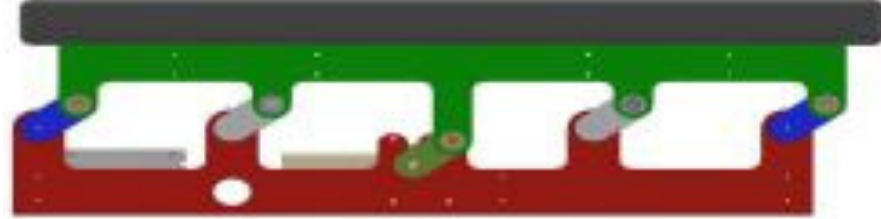
Figure 2. Modified four-bar link mechanism.